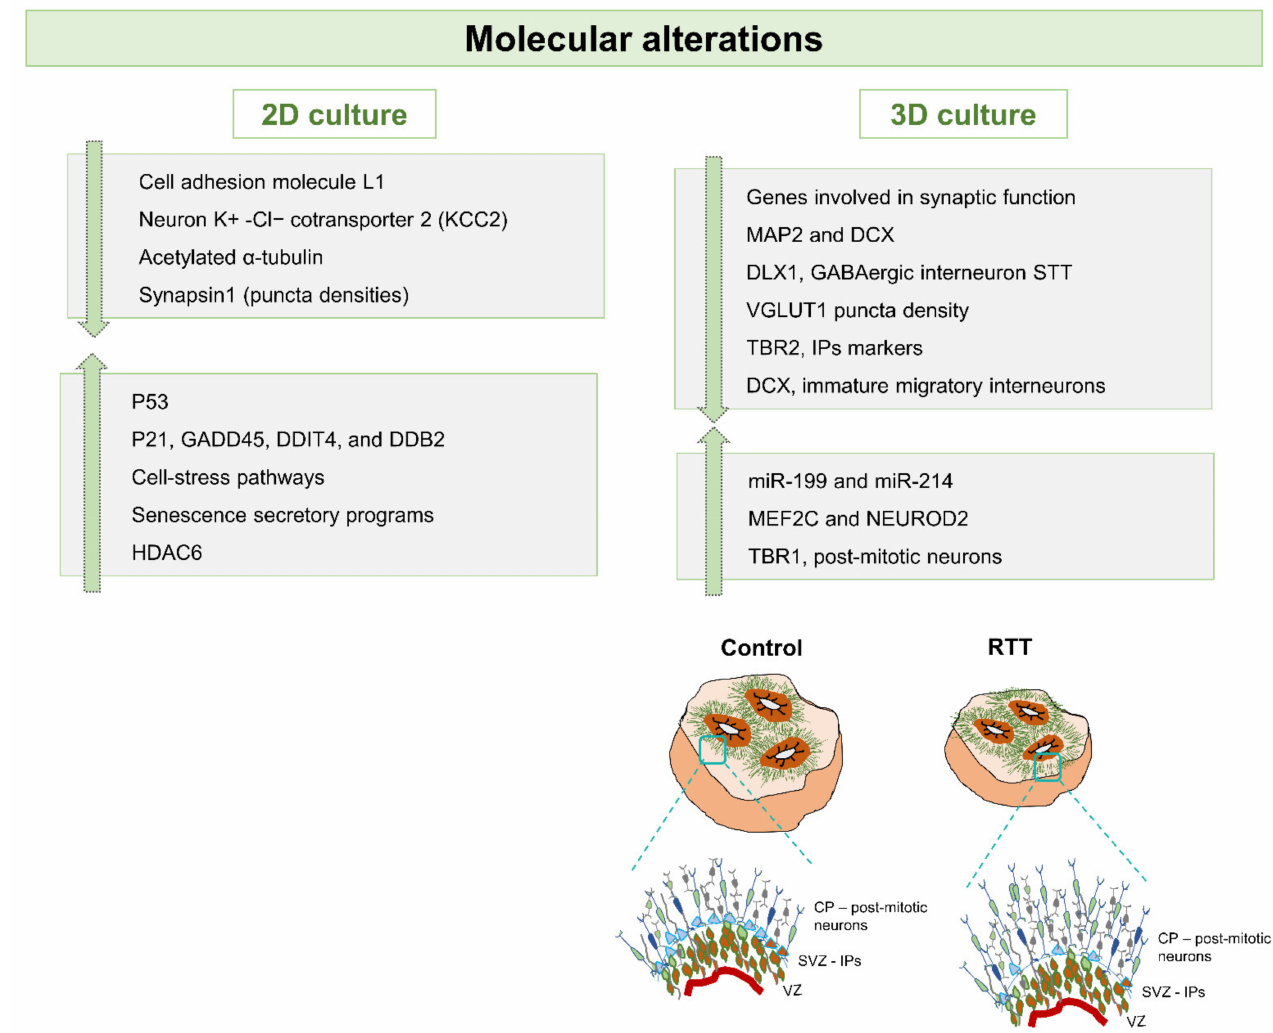
Figure 4. Schematic view of RTT-associated molecular alterations observed in both 2D and 3D cultures of brain cells derived from hiPSCs. Genes related with both GABAergic interneurons (DLX1) and glutamatergic cortical neurons (VGLUT, TBR1) have been observed to have altered expression in RTT models. Additionally, alterations in molecules associated with cell stress and apoptosis, and involved in synaptic function are also highlighted. The schematic view highlights the differences in cortical layer structures, mainly the increase in the thickness of the cortical plate (CP) and the absence/decrease of intermediate progenitors (IPs) in the subventricular zone (SVZ), laying adjacent to the ventricular zone